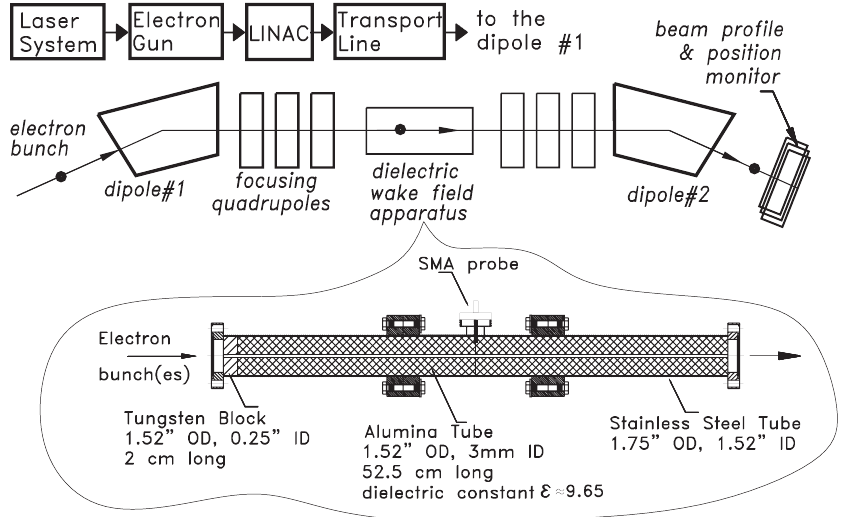
FIG. 2. Schematic of the experimental setup and the dielectric wakefield apparatus (DWA).